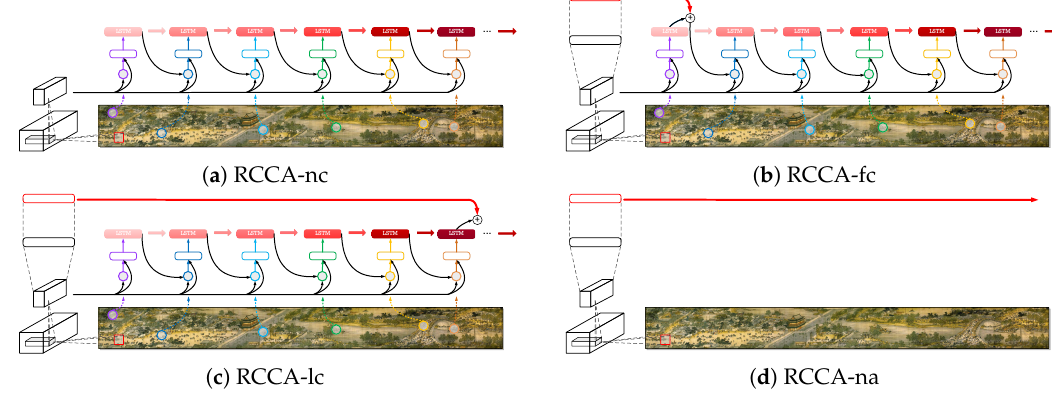
Figure 3. Different usages of context information in the four RCCA variants.